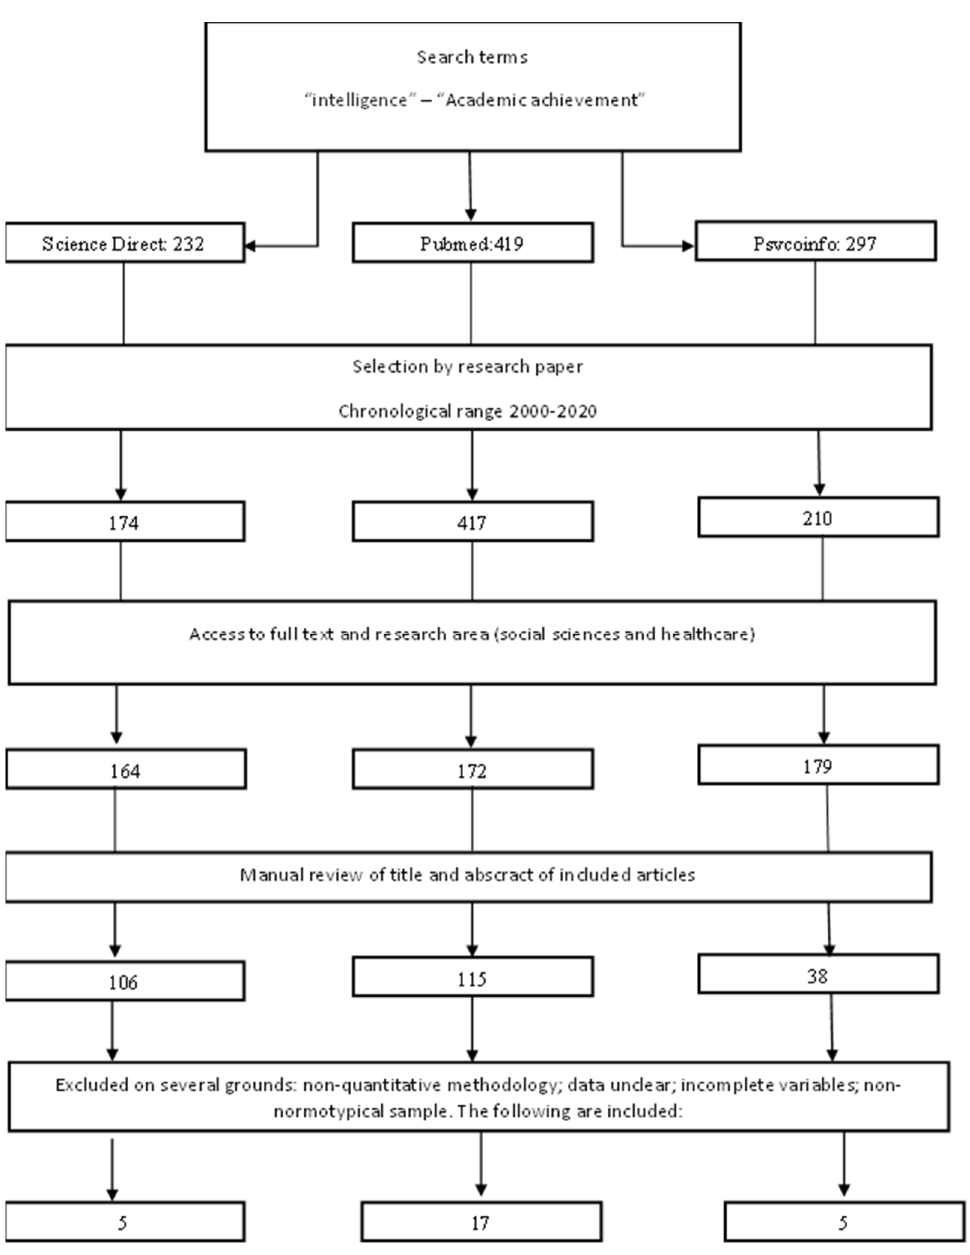
Figure 1. Flowchart of search methodology.